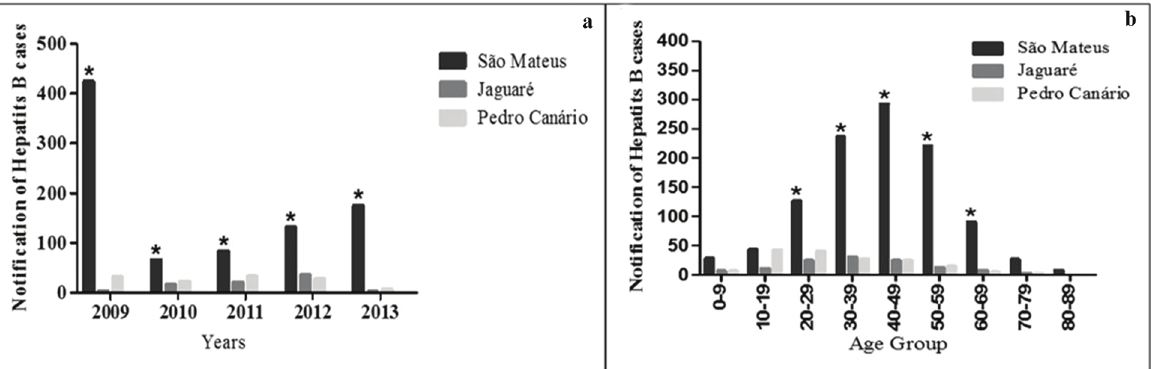
Figure 3 - Analysis between the notifications of Hepatitis B cases through the SINAN databases in the cities of the Northern Region of the Espírito Santo (São Mateus, Jaguaré and Pedro Canário). a ) Number of reported cases from 2009 to 2013, *p < 0.0313. b ) Number of reported cases of hepatitis B from 2007 to 2013 stratified byage group, * p <